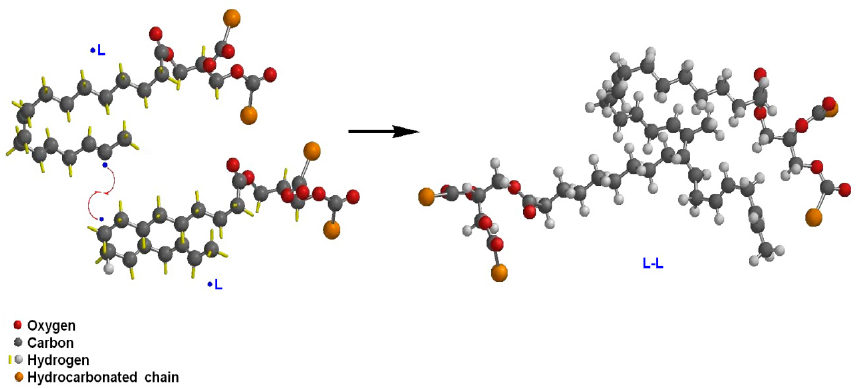
Figure 2. Lipid crosslinking mechanism from the reaction of two lipid